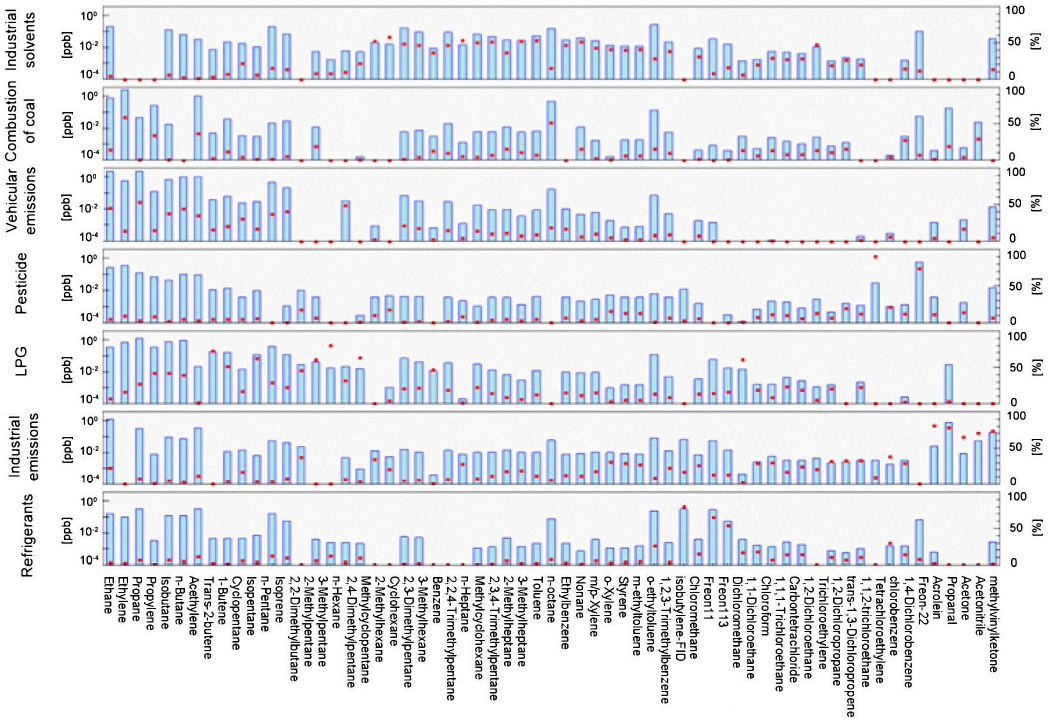
Figure 4. Source profiles. The blue bars represent the concentration and red dots represent the percentage that each species is explained by the factor.